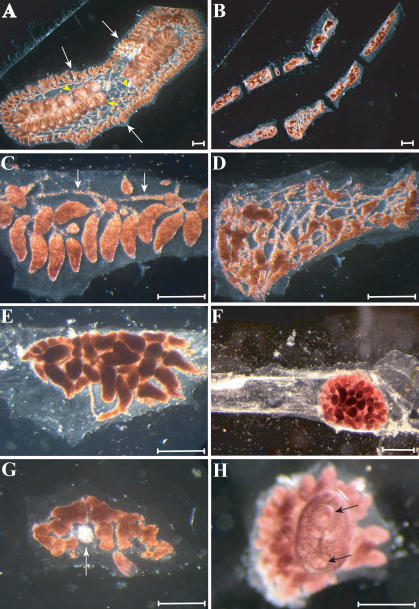
Morphological Events during WBR in B. leachi
(A) A colony of B. leachi composed of two systems of genetically identical zooids (yellow arrowheads), each 2–3 mm long, embedded within the tunic. A network of blood vessels connects all zooids within a colony, from which pear-shaped vascular termini (ampullae) extend toward the colony margins (arrows).(B–H) Experimentally induced regeneration. The zooids and palleal buds in the center of the colony were cut out, leaving behind the marginal ampullae (B). Segments of several ampullae, 1–3 d after amputation, created a new blood vessel network (C) and (D), respectively (arrows). Isolated ampullae changed their orientations and shapes 6–7 d postseparation within the tunic matrix and coalesced into each other (E). Vasculature movements were more conspicuous when blood vessels were spaced out, creating a dense mass of vessels on one side of the fragment and a semitransparent gelatinous tunic matrix deprived of blood cells and blood vessels on the other side (F). By days 8–9, an opaque mass of blood vessels was formed, followed by the formation of an internal small transparent vesicle (G) (arrow). By days 10–14, a fully operating filter-feeding zooid equipped with functional atrial and peribranchial siphons, both facing upwards as in normal zooids, developed from the opaque mass of blood vessels (H) (arrows). The scale bar represents 1 mm.